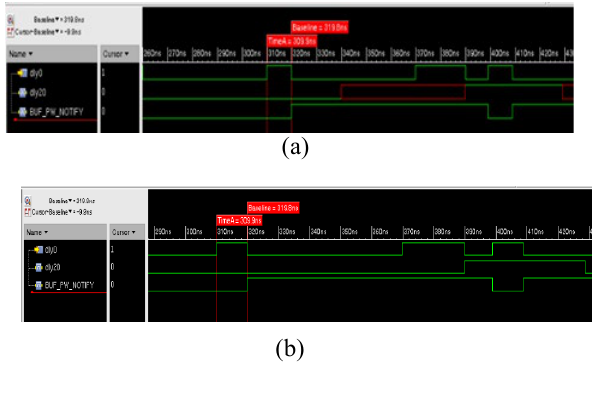
Figure 14. Simulation results